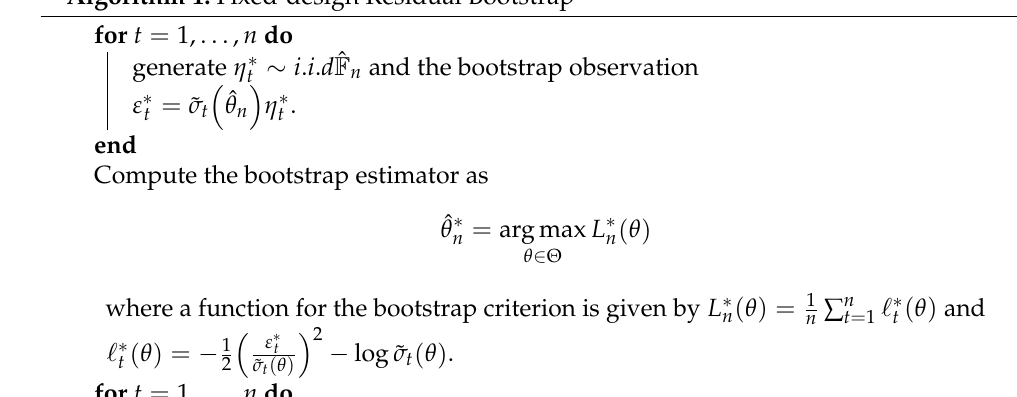
Algorithm 1: Fixed-design Residual